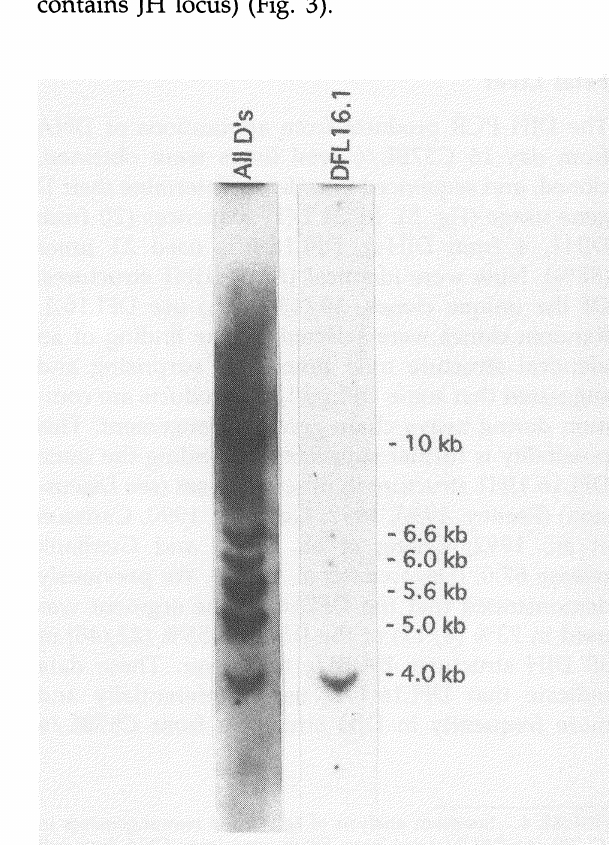
FIGURE 3. Southern analysis of germline DH locus in C57BL/6 DNA: Genomic DNA was extracted from C57BL/6 kidney electrophoresed on 0.8% agarose gel and probed by the method of Southern (1975) (28). The probes used are summarized in Fig. 1. The lane shown on the left was hybridized with a combination of 5’ DFL16.1, 5’ DSP, and DQ52 probes. After exposure, the filter was stripped, exposed, and reprobed with the DFL16.1 probe and is shown in the right-hand lane. Multiple D probes detected germline bands of 4.0-, 5.0-, 5.6-, 6.0-, 6.6-, and 10.0-kb fragments, as indicated. The DFL16.1 probe detected only a 4.0-kb